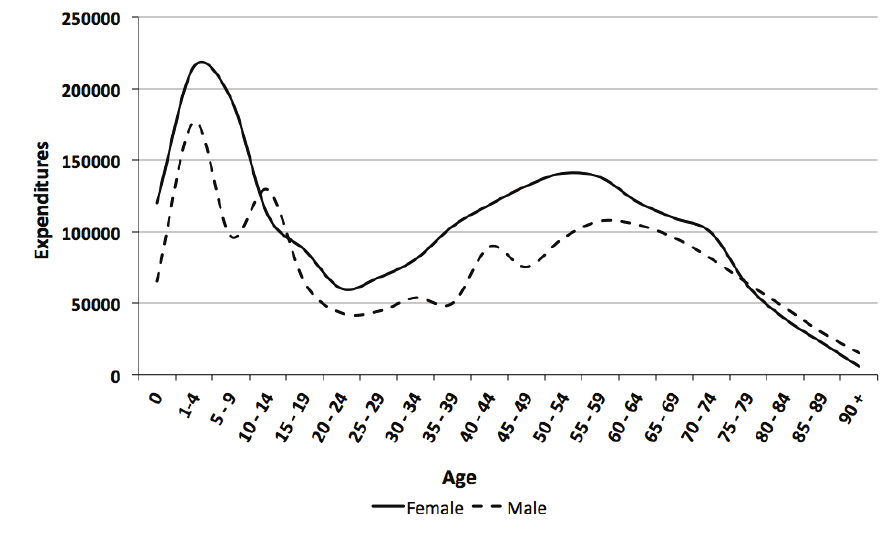
Figure 2: Estimated increase in per capita hospital expenditures associated with the last year of life at different ages